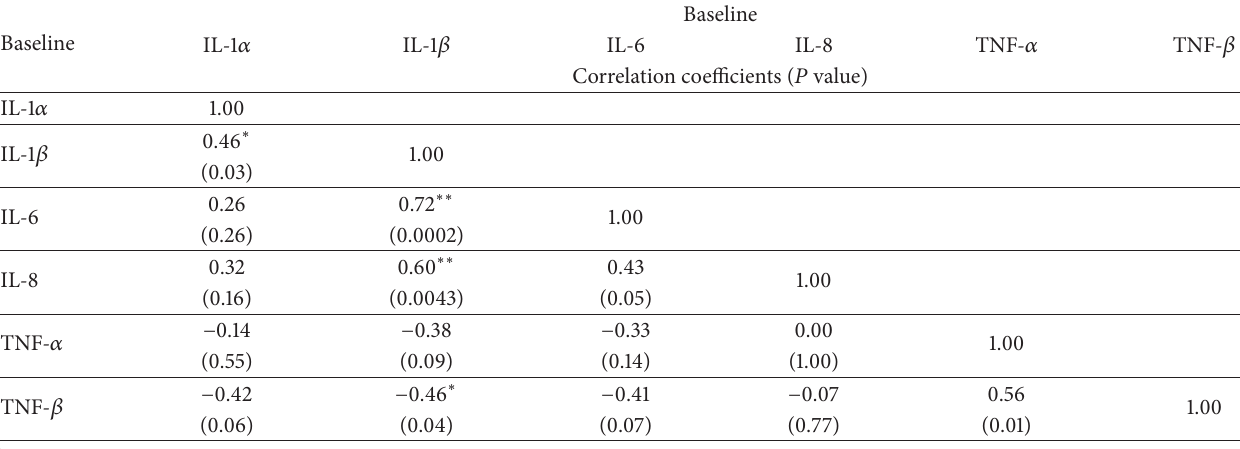
Table 3: Correlation between baseline salivary proinflammatory cytokines in patients with periodontitis.